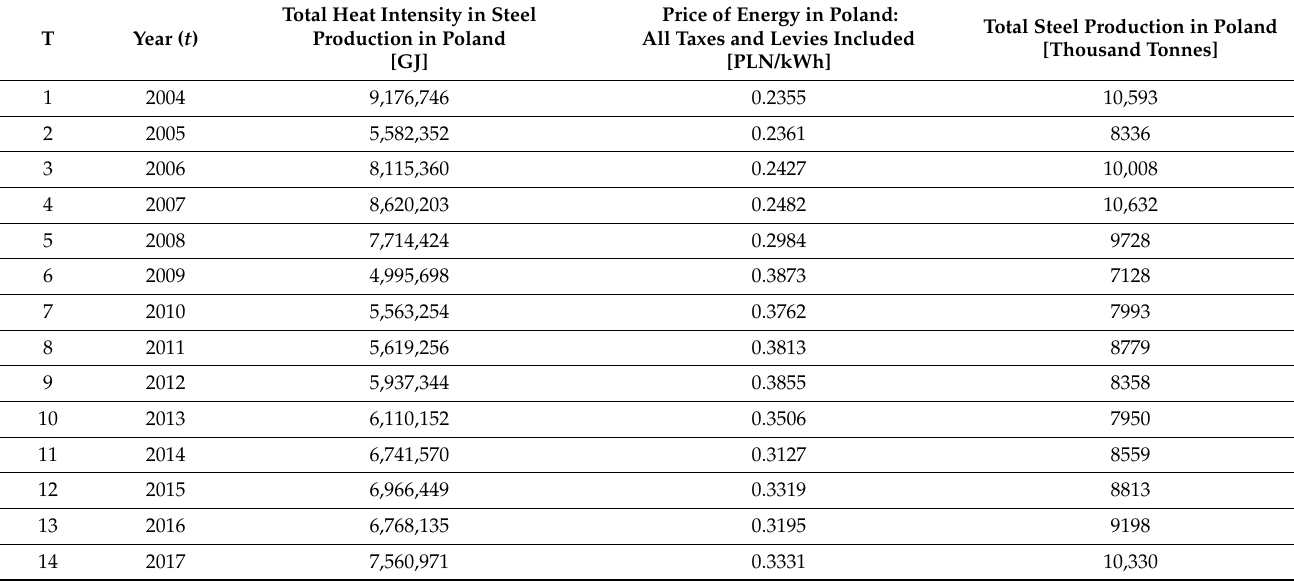
Table 4. Data used in the econometric model No.